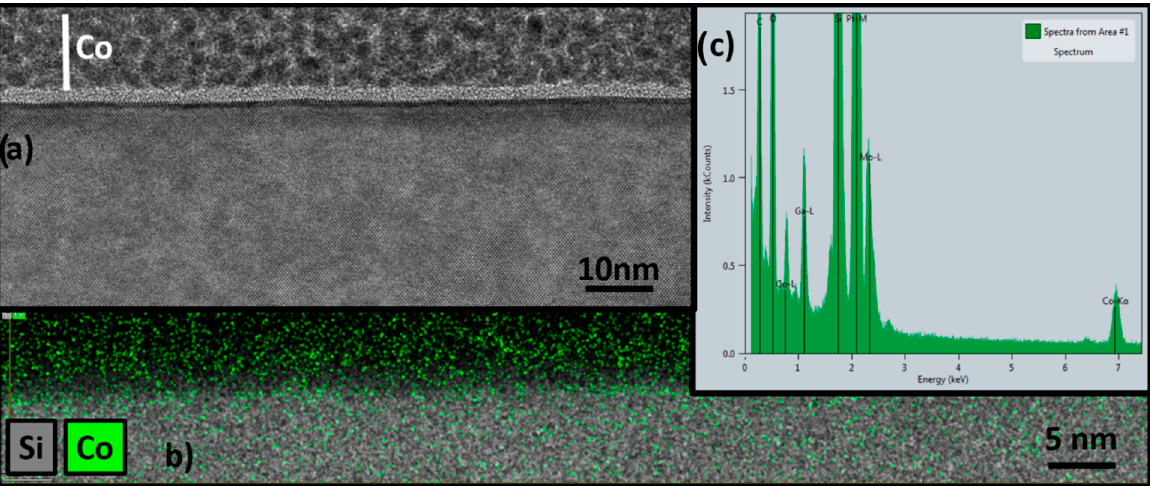
Figure 4. ( a ) Cross-sectional TEM image of cobalt nanofilm on silicon wafer; ( b , c ) EDX mapping of cobalt film on the silicon microreactor.